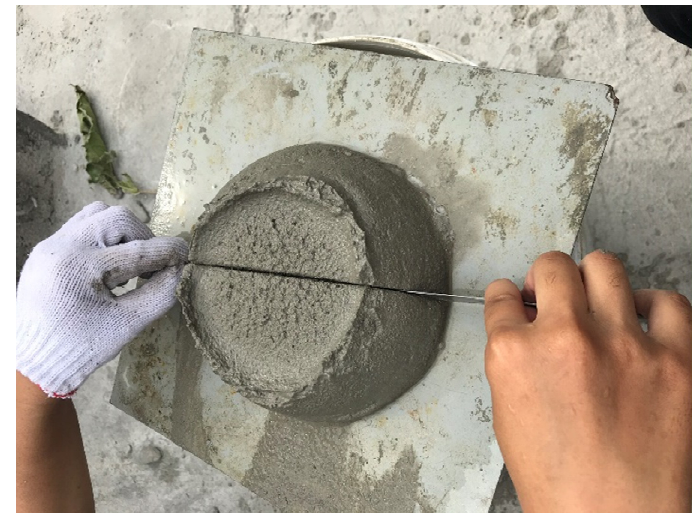
Figure 3. Measurement of the spreadability of foamed concrete.